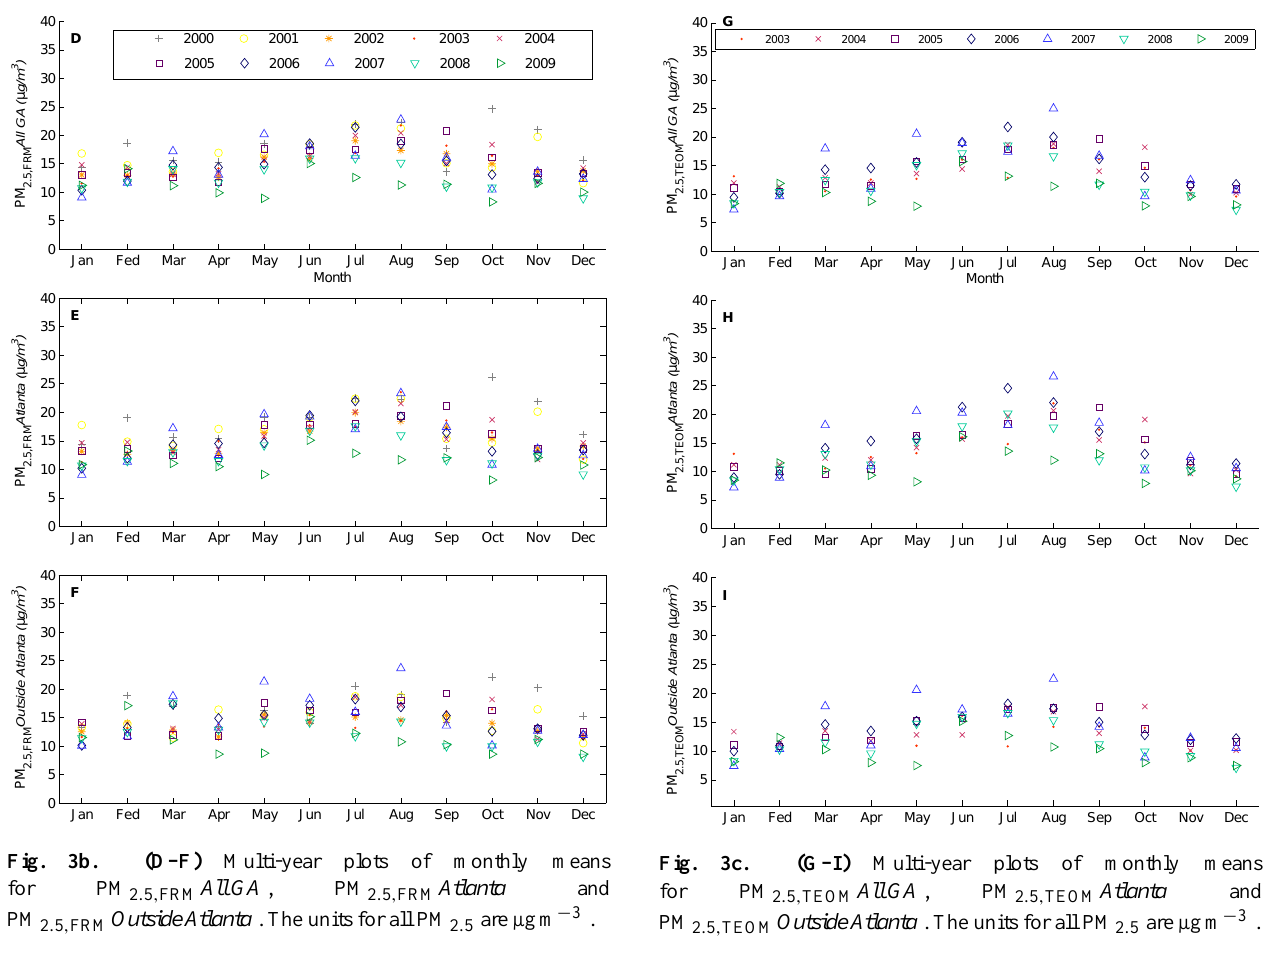
the Northwestern US (http://droughtmonitor.unl.edu/). There